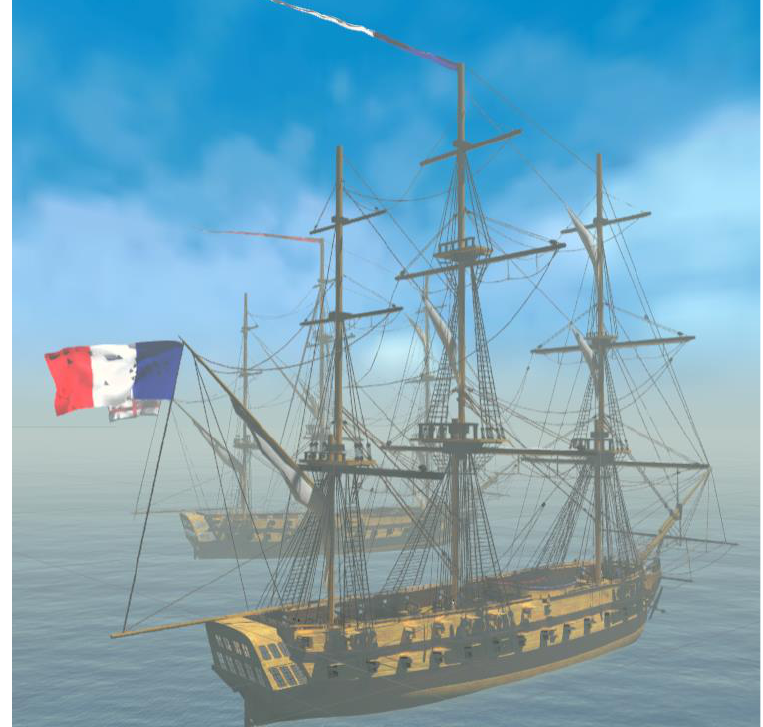
Figure 17. The French frigate “Armide”. Screenshot from Unity3d.